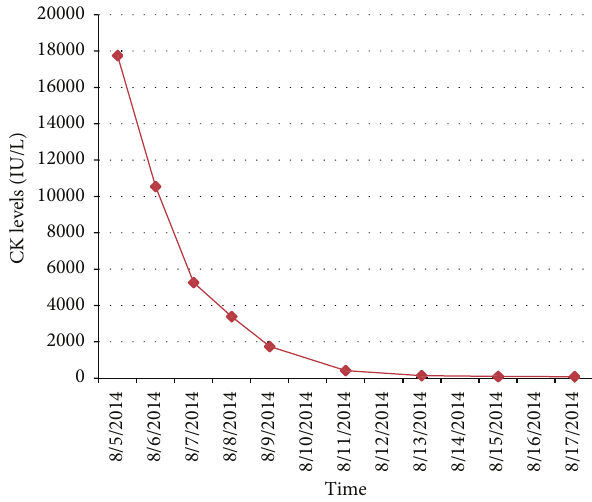
Figure1:TrendintheelevationinCKlevelsnotedaftersecondcycle of chemotherapy with nelarabine in our patient (note: cycle 1 was initiated on 6/27/2014 and cycle 2 on 07/29/2014; last dose was given 08/02/2014, no baseline CK levels to compare